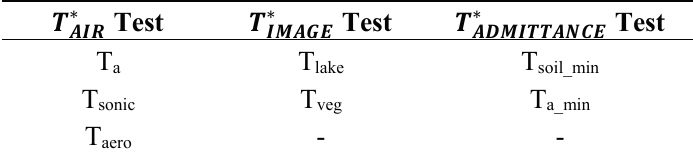
Table 1. T * used within (cid:1846) (cid:3002)(cid:3010)(cid:3019)∗ (cid:1846) (cid:3010)(cid:3014)(cid:3002)(cid:3008)(cid:3006)∗ and (cid:1846) (cid:3002)(cid:3005)(cid:3014)(cid:3010)(cid:3021)(cid:3021)(cid:3002)(cid:3015)(cid:3004)(cid:3006)∗